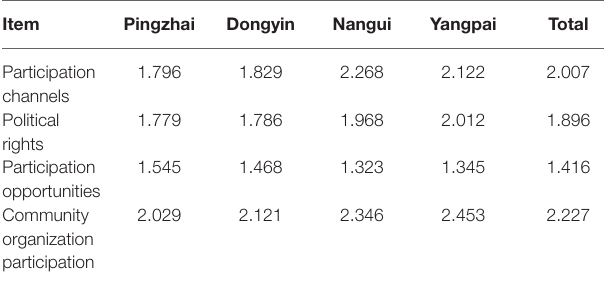
TABLE 5 | Means analysis of political empowerment perception. Item